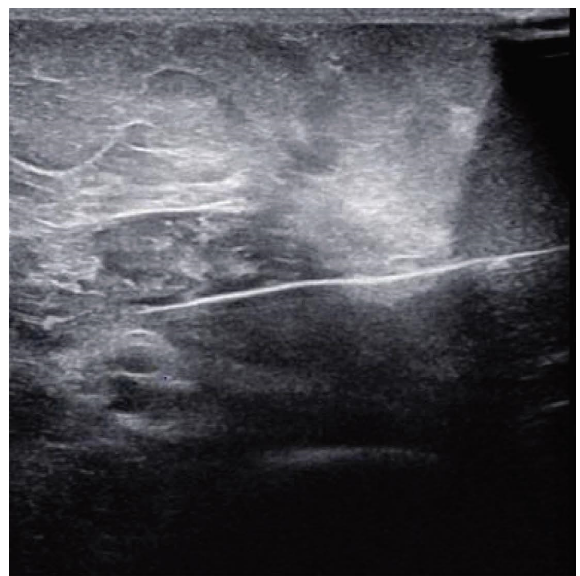
Figure 1: Transverse sonographic view of the median nerve proximal to the left antecubital fossa, with an in-plane stimulator needle superior to the median nerve. Due to poor quality, the sonographic images of the other two cases were not